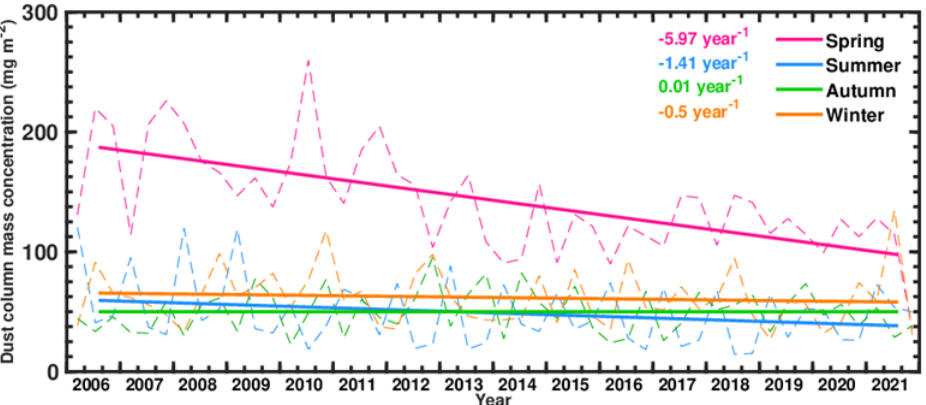
Figure 5. Dust column mass concentration of MERRA-2 tavgM_2d_aer_Nx monthly data over the Jianghan Plain from 2006 to 2021. The different colors indicate in spring, summer, autumn, and winter. The straight lines are the linear fits of the corresponding data points. The slopes for each season are given accordingly.